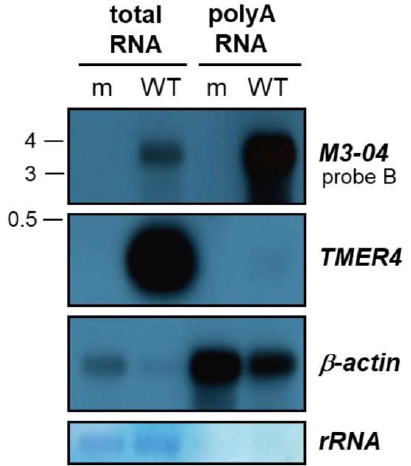
Figure 4. M3-04 is polyadenylated. Poly(A)-selected or total RNA was harvested at 18 hours from either mock-infected (m) or wild-type MHV68-infected (WT) NIH 3T12 fibroblasts. Northern blot was performed using probe B to detect M3-04 transcript. TMER4 and β-actin transcripts were detected using strand-specific probes. Methylene blue staining is shown for rRNA as a loading and poly(A) selection control.